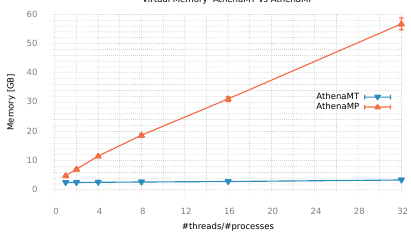
Figure 7: Memory Occupancy (Vir- tual Memory) of AthenaMT (blue) vs. AthenaMP (orange), as a function of the number of threads or processes, respec- tively.